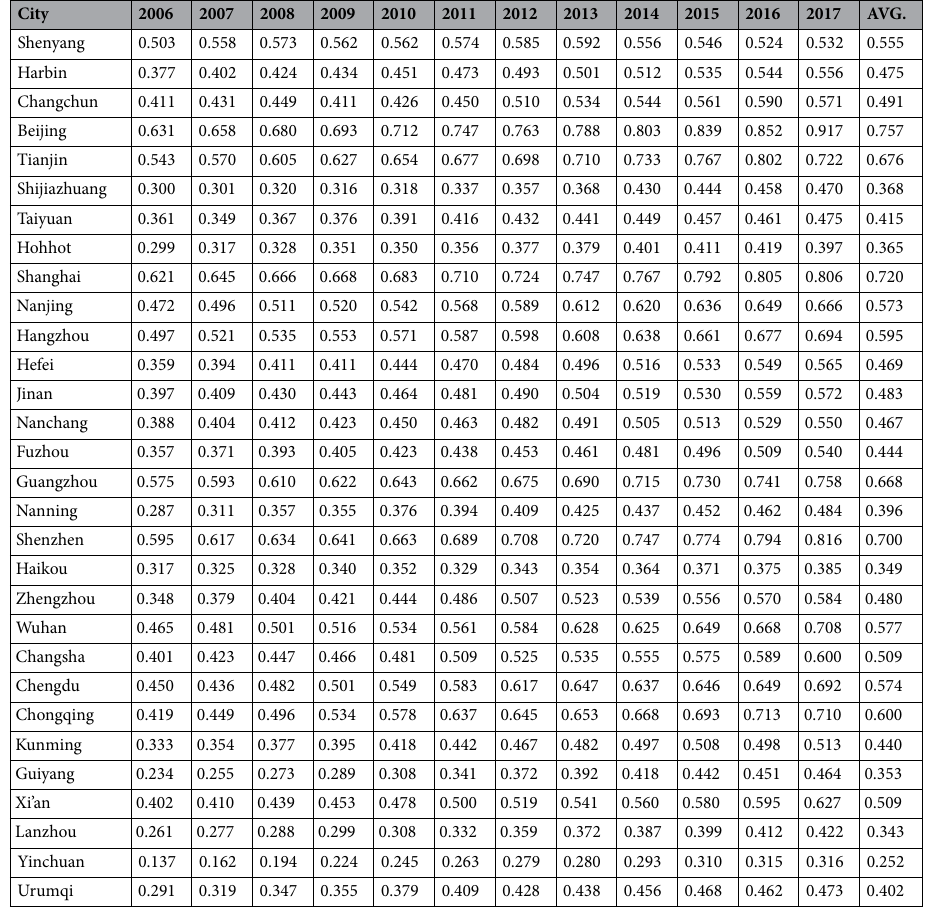
Table 5. CCD of low-carbon-economic index from 2006 to